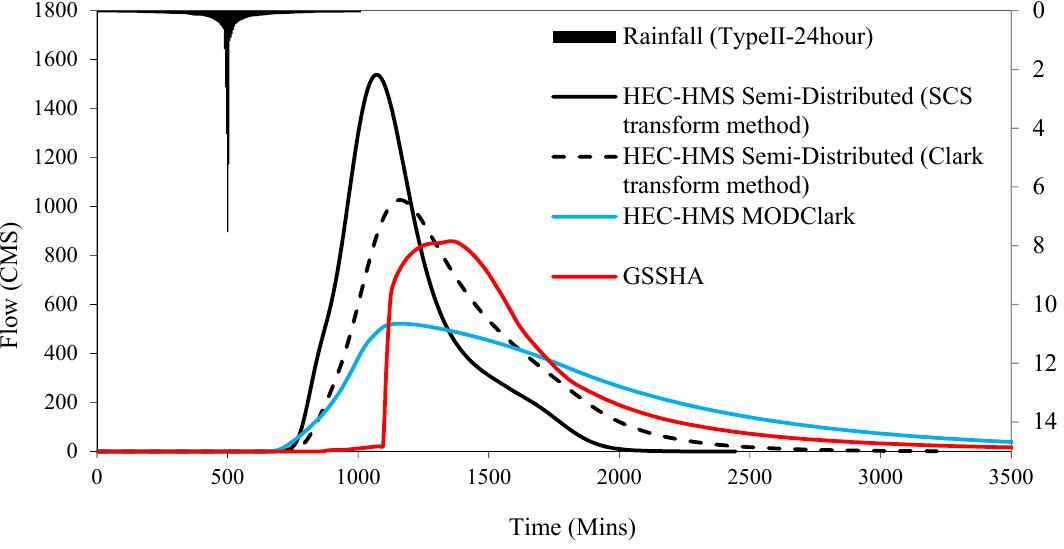
Figure 19. Comparison between simulated outlet discharge for HEC-HMS and GSSHA models. Table 5. Comparison between GSSHA and HEC-HMS (semi-distributed and ModClark) models. Model Type Model